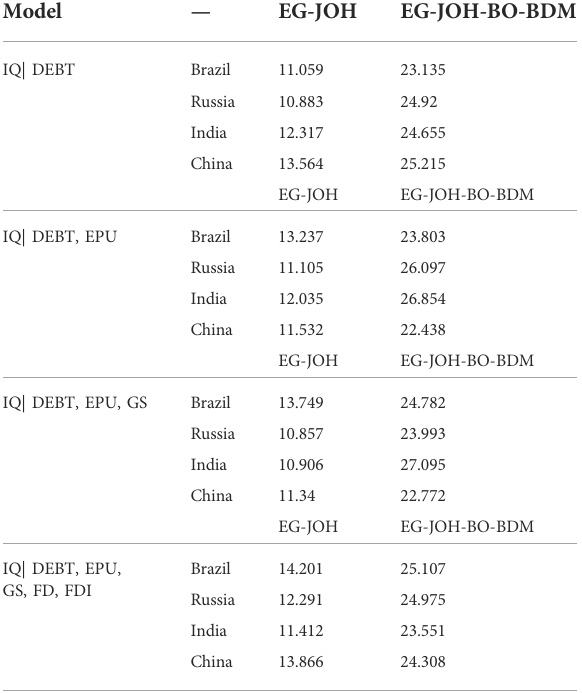
TABLE 4 Results of Bayer-hacked combined counteraction tests. Model